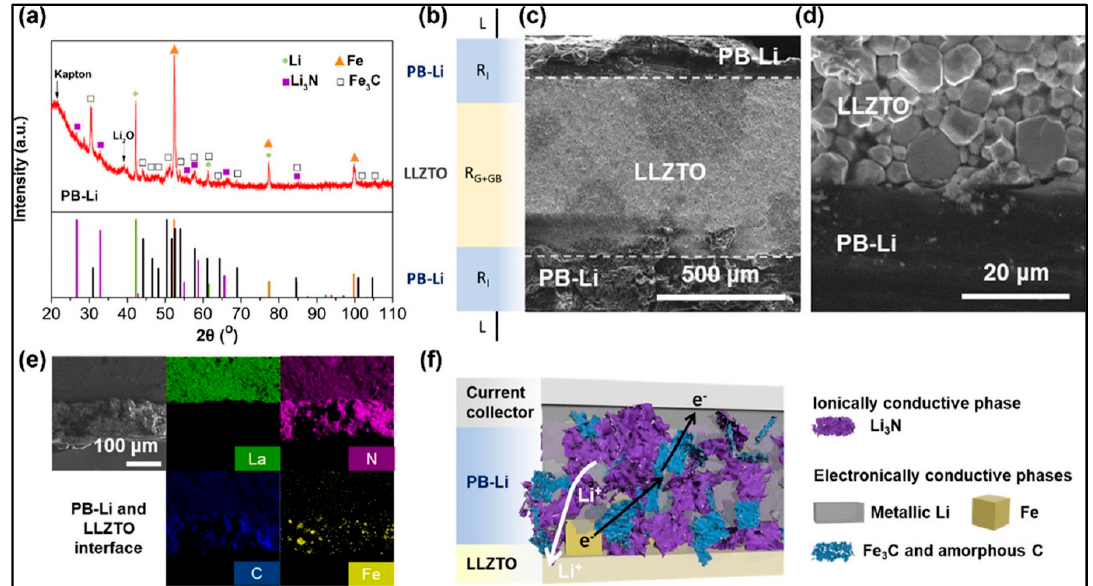
Figure 6. (a) X-ray diffraction pattern of synthesized PB-Li-anode; ( b ) explanatory presentation; ( c , d ) Scanning electron microscopy image; ( e ) EDS Mapping; ( f ) explanation of ionic and electronic path- ways. (Reprinted with permission from [118]; Copyright 2022, ACS Appl. Mater. Interfaces 2022 , 14,